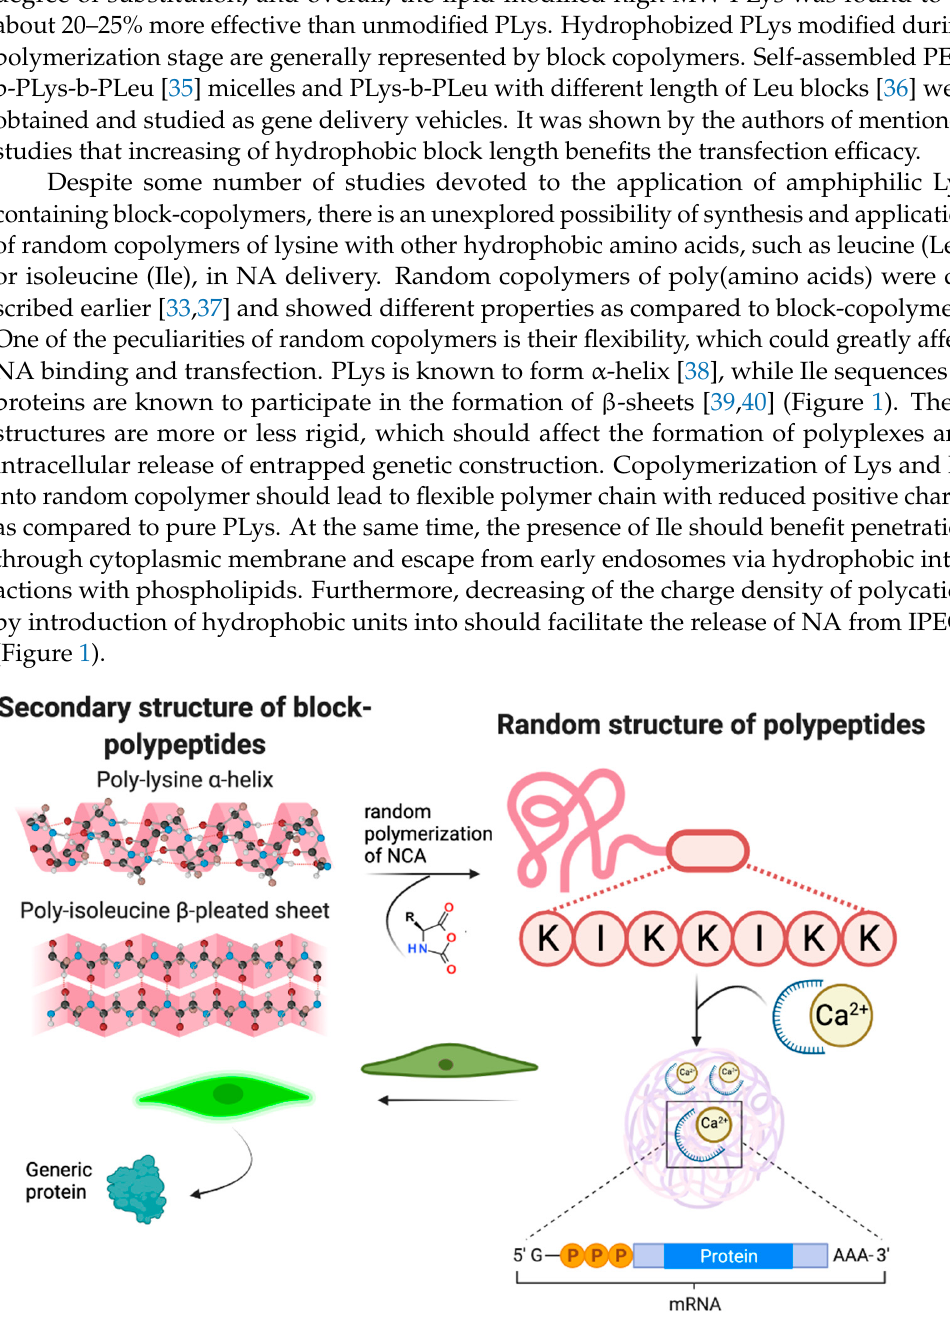
Figure 1. Flexibility of polyplexes based on P(Lys-co-Ile) as compared to PLys (K) and PIle (I), and its possible effect on transfection.